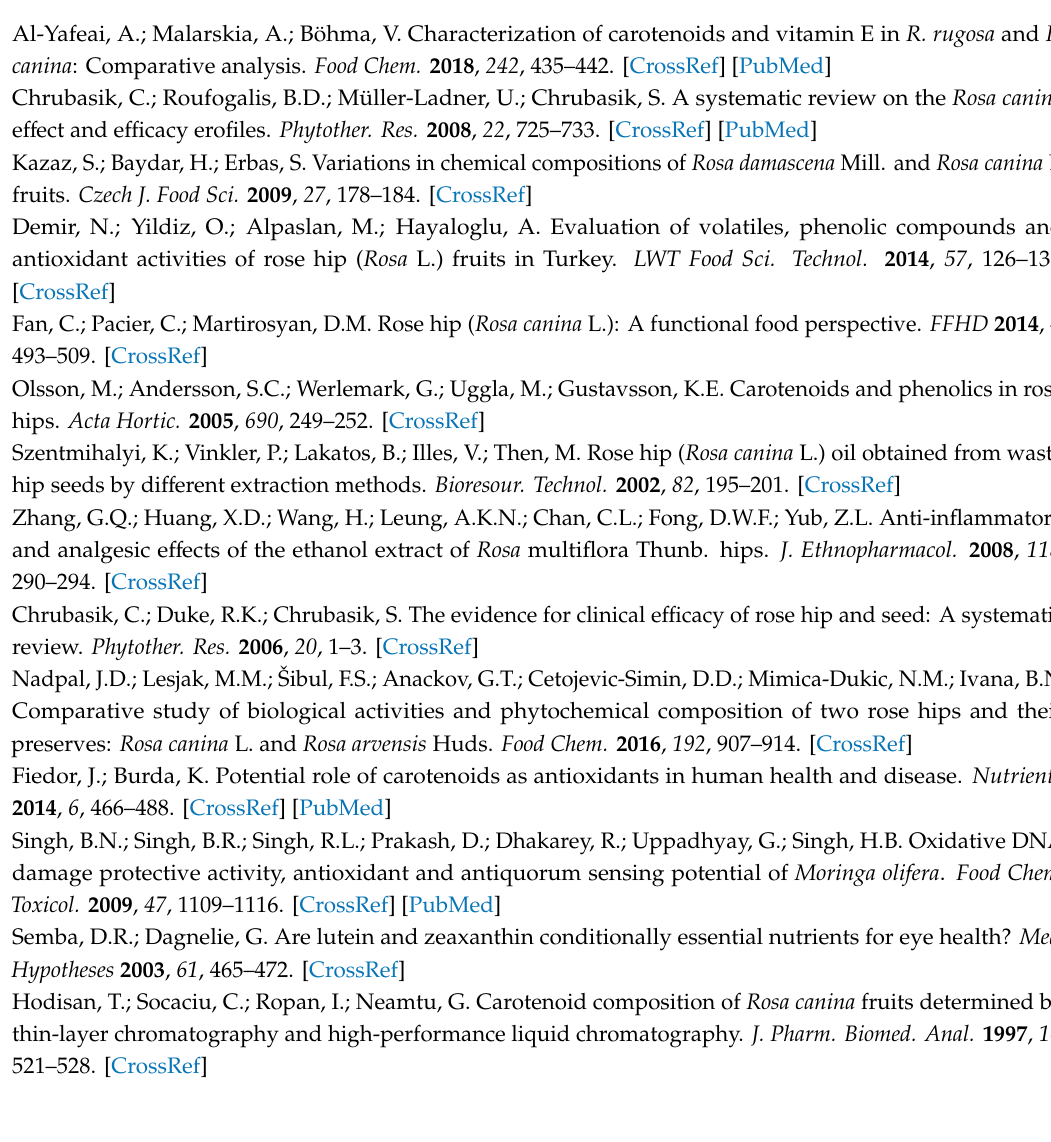
Figure S1: Standard curves for all carotenoids identified in experiment in organic rose fruits and seeds experiment, Figure S2: Standard curves for all phenolic acids identified in experiment in organic rose fruits and seeds experiment, Figure S3: Standard curves for all flavonoids identified in experiment in organic rose fruits and seeds